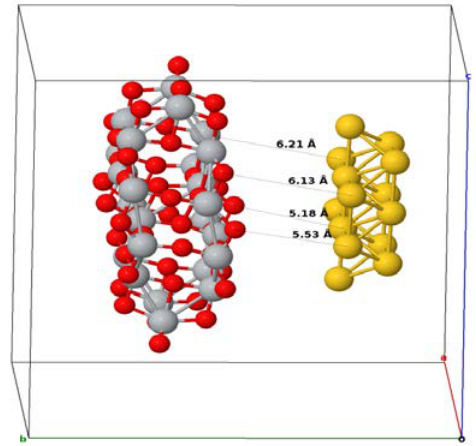
Fig. 5. Optimized geometry of the considered TiO 2 /Au nanocomposites constructed from anatase nanoparticle and Au monolayer.